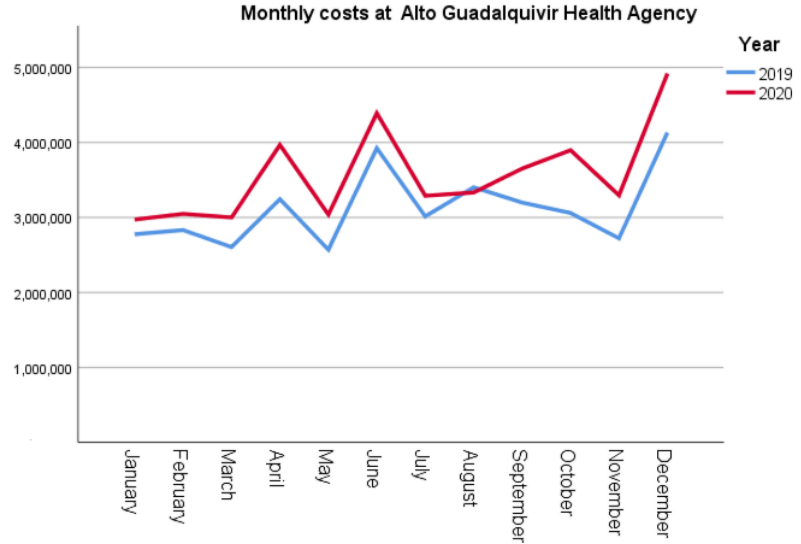
Figure 1. Comparative analysis of monthly costs at Alto Guadalquivir Health Agency.